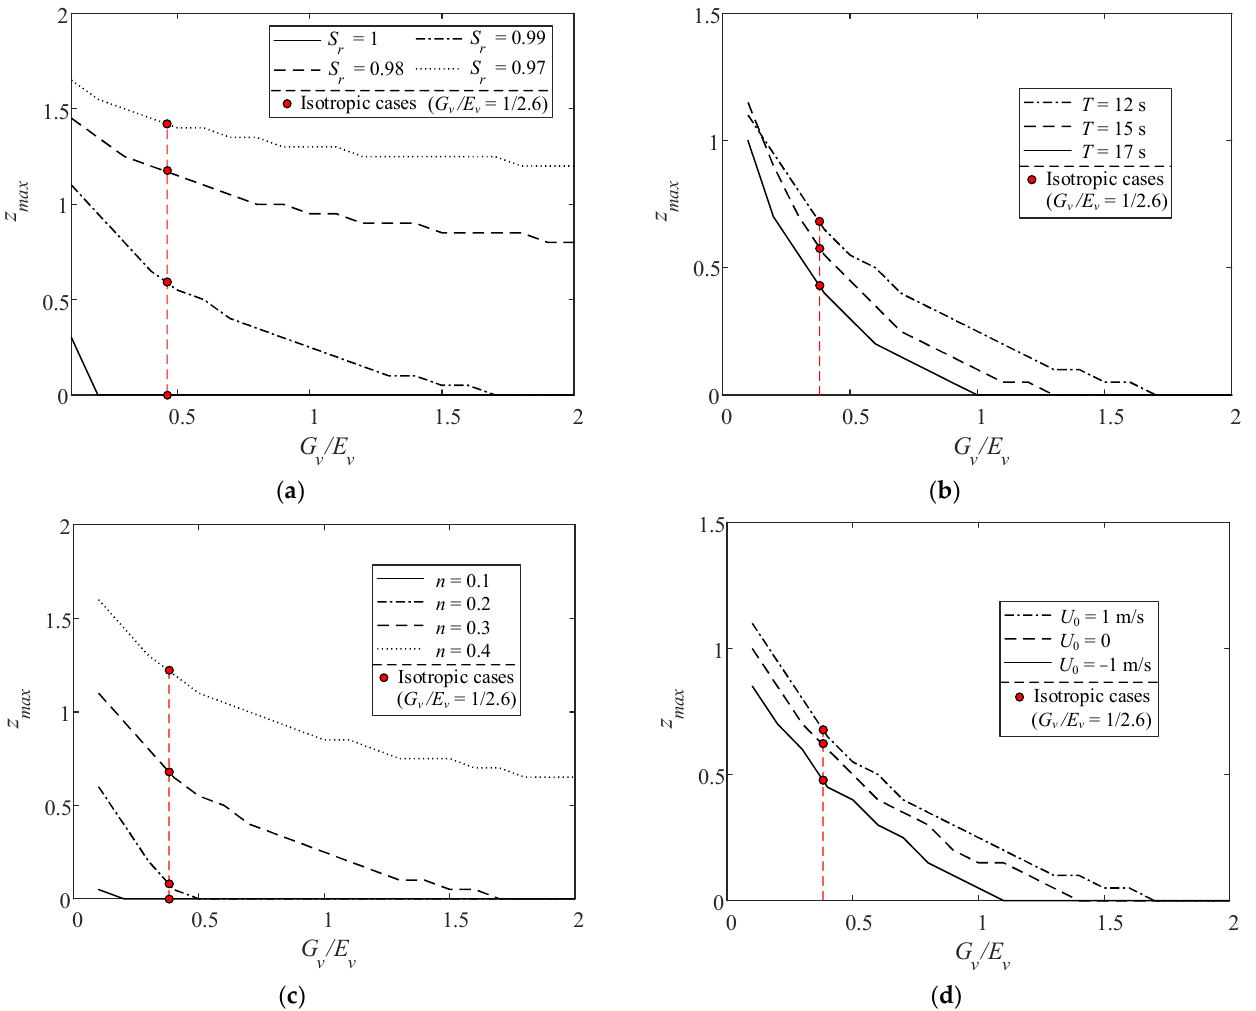
Figure 14. Maximum liquefaction depth z max varying with G v / E v for various ( a ) degrees of saturation, ( b ) wave periods, ( c ) soil porosities, and ( d ) current velocities.